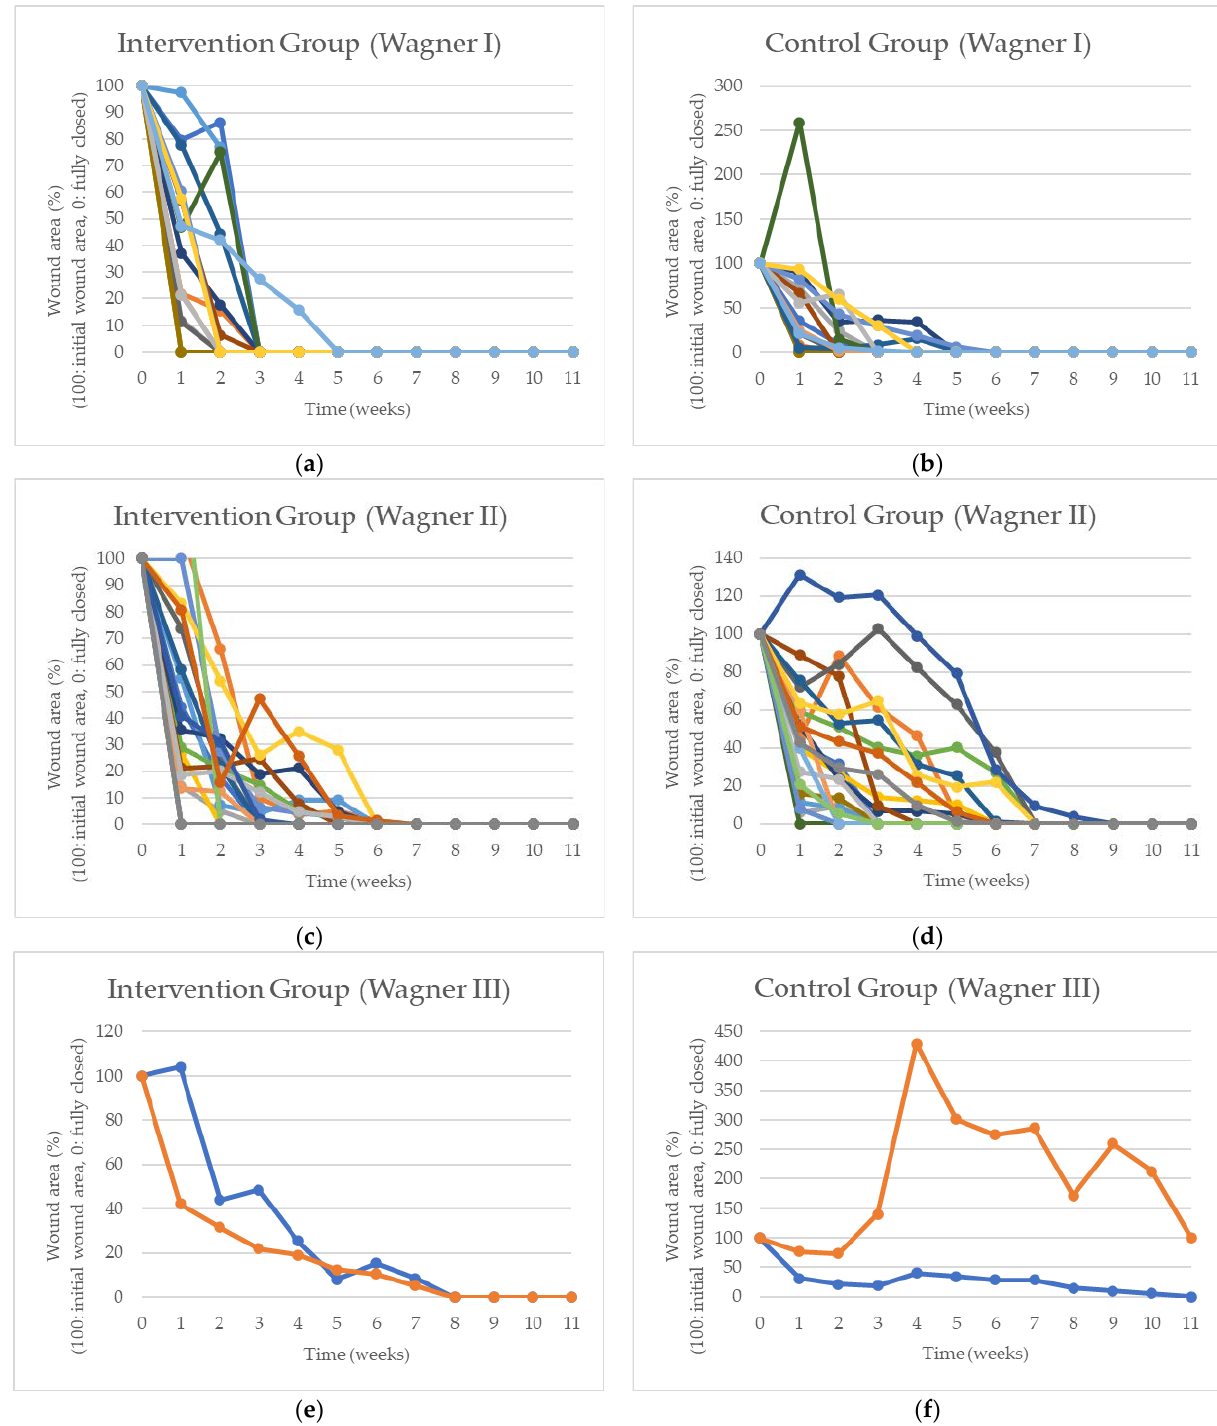
Figure 3. Graphs of wound area for the intervention and control groups. The wound area is measured once every week for 12 weeks. Each line corresponds to the healing rate of each patient. ( a ). Intervention Group (Wagner I). ( b ). Control Group (Wagner I). ( c ). Intervention Group (Wagner II). ( d ). Control Group (Wagner III). ( e ). Intervention Group (Wagner III). ( f ). Control Group (Wagner